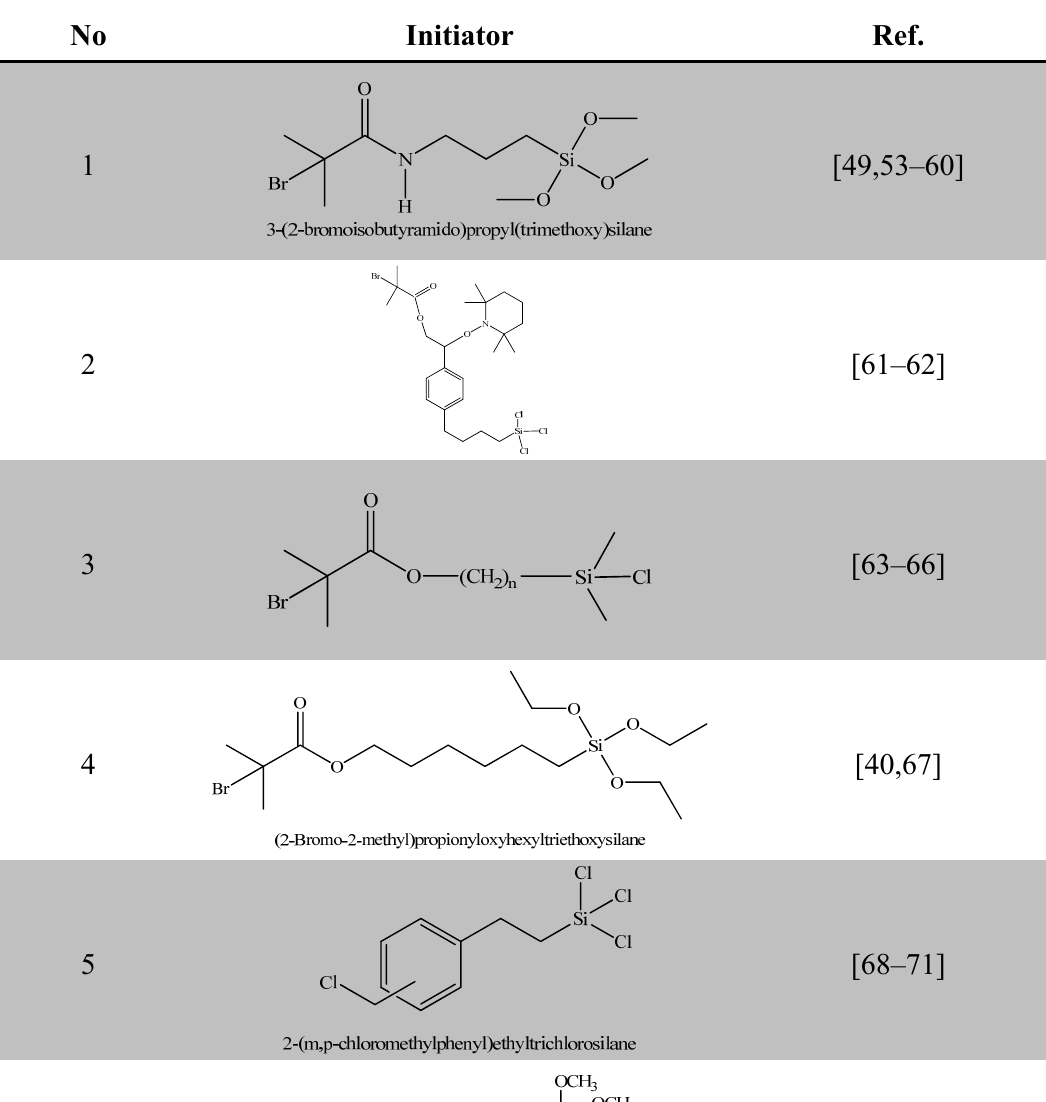
Table 1. Initiator molecules grafted on the surface of silica